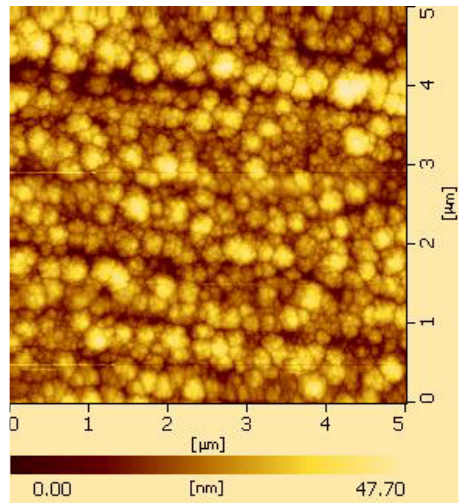
Figure 22: AFM Picture of TiSiBC hard coating deposited by Mag- netron